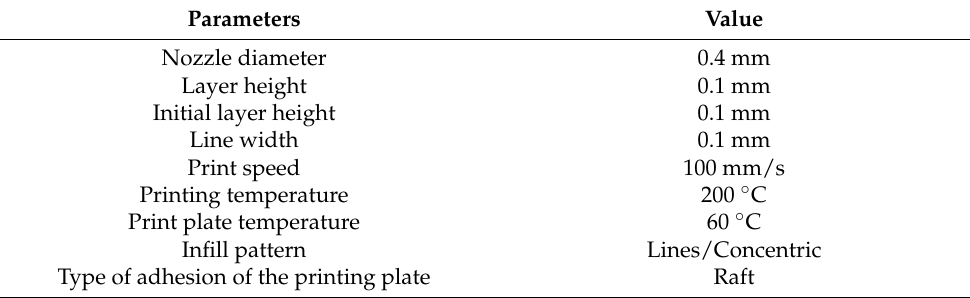
Table 2. 3D-printer parameters used to